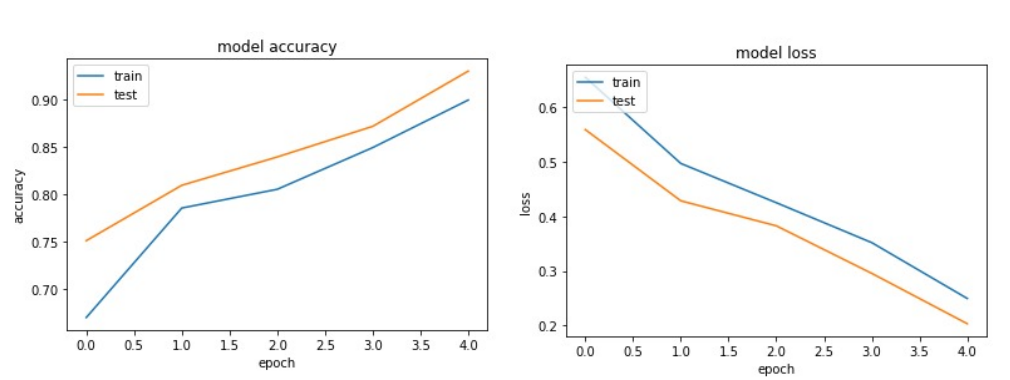
Fig. 10. Accuracy vs. Epochs and Loss vs. Epochs for training and testing of type 3.